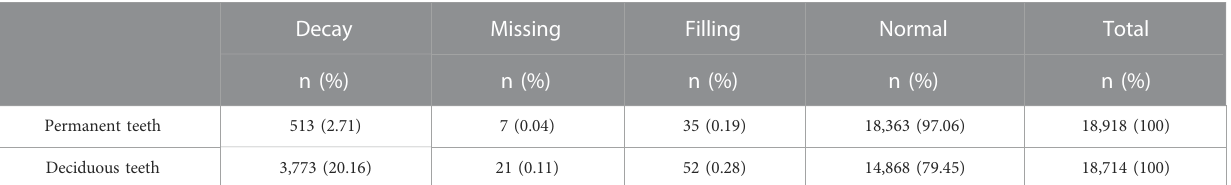
TABLE 3 Incidence of caries (number of teeth).